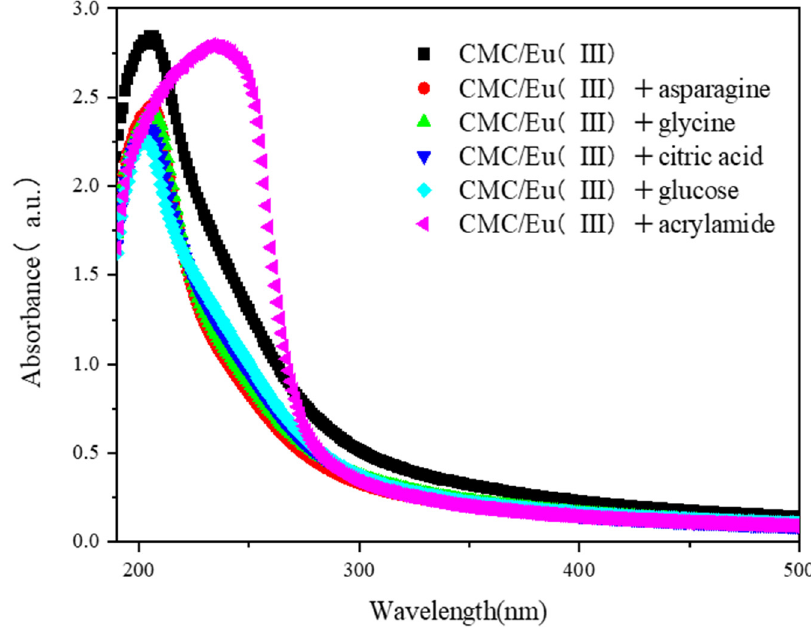
Figure 10. The effect of acrylamide (0.1 mmol/L) on UV–vis spectra of CMC/Eu ( Ⅲ ) fluorescent probe .